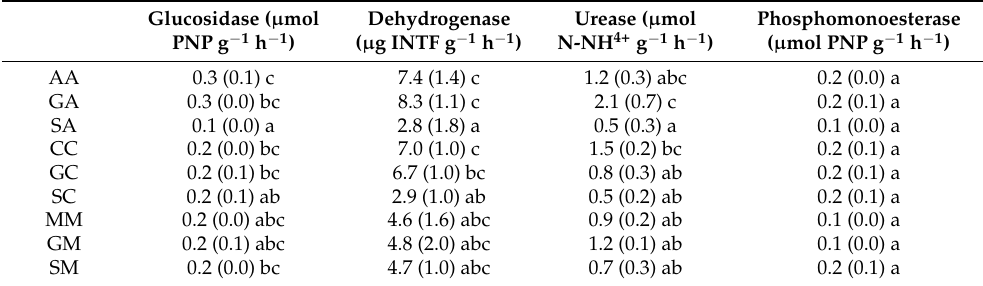
Table 5. Mean values of the soil enzymatic activities analyzed at the end of the